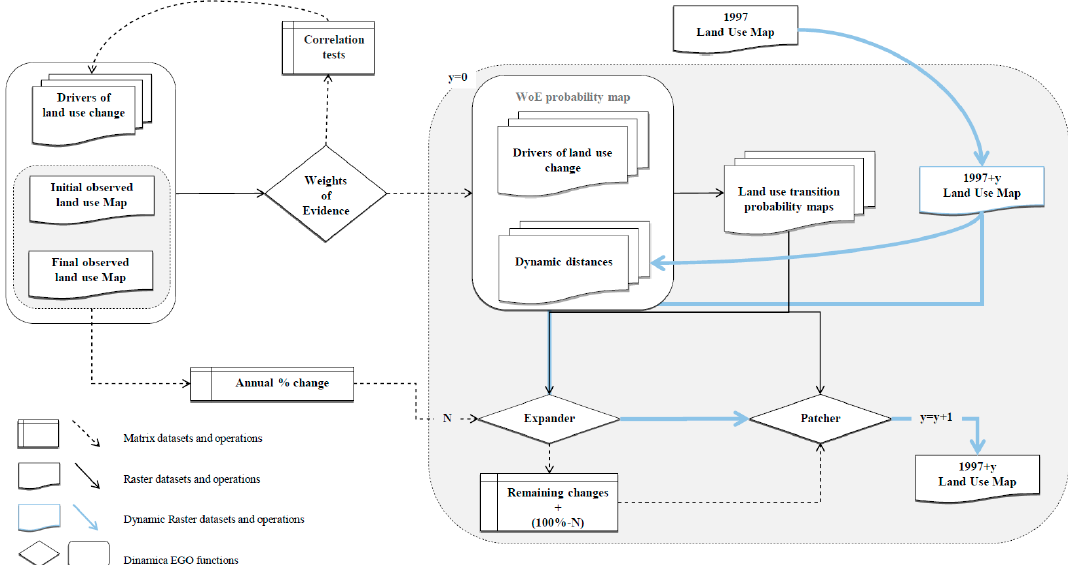
Figure 2. Flow chart illustrating the land use/cover change Dinamica Environment for Geoprocessing Objects (EGO) modelling framework.